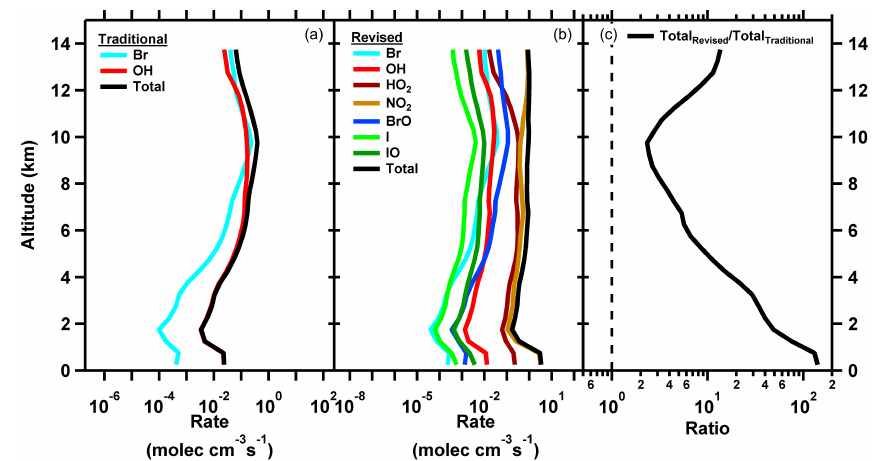
Figure 8. Box model results for the scavenging of the HgBr adduct as a function altitude for two different reaction schemes: traditional (a) and revised (b) . Panel (c) contains the ratio of the total rates (black traces in (a) and (b) to show the enhancement in the rate of the scavenging reaction when other reactants are taken into